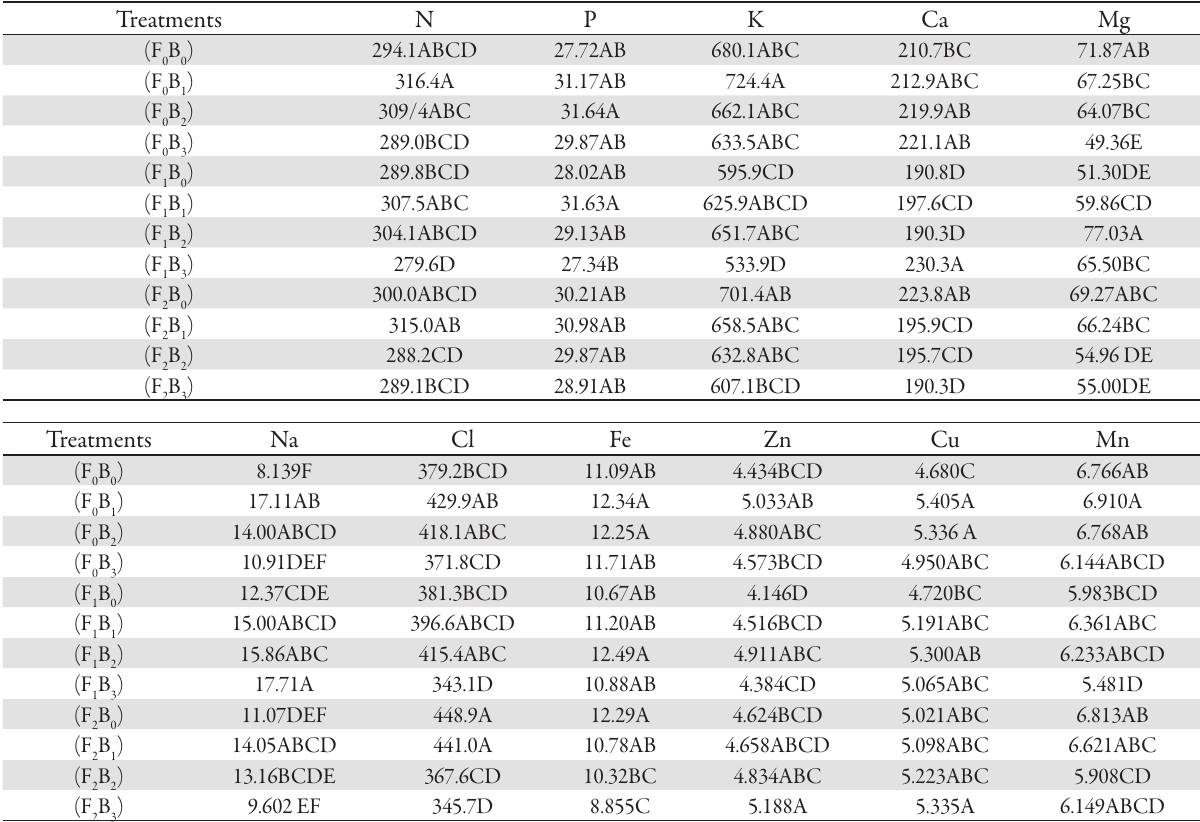
Tab. 5. The comparison of mean for the interaction effect between fungus and bacterium on uptake of macro and micro elements and elements of Na and Cl (mg pot -1 )